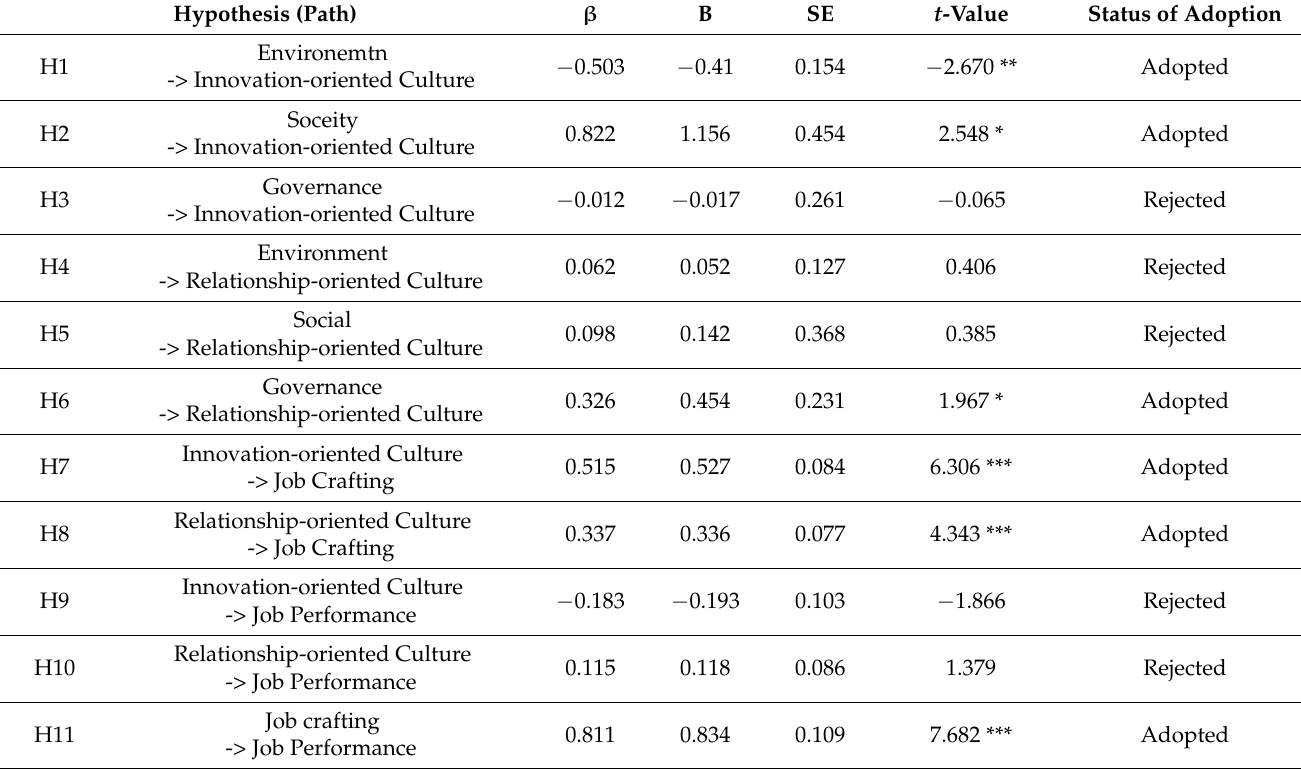
Table 5. Discriminant